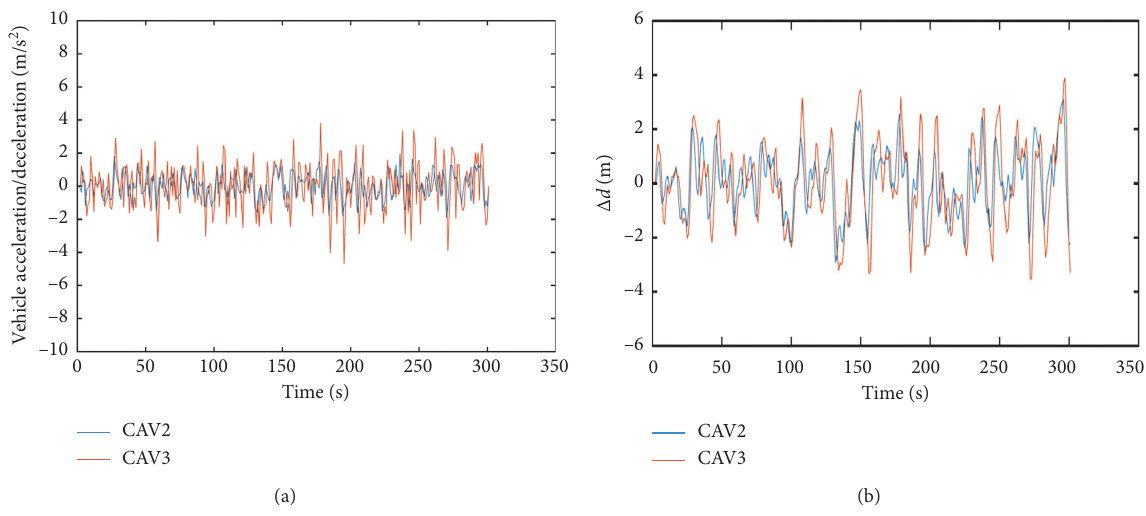
Figure 13: The fleet control under low stability requirement. (a) The acceleration of CAVs. (b) The control error of CAVs.